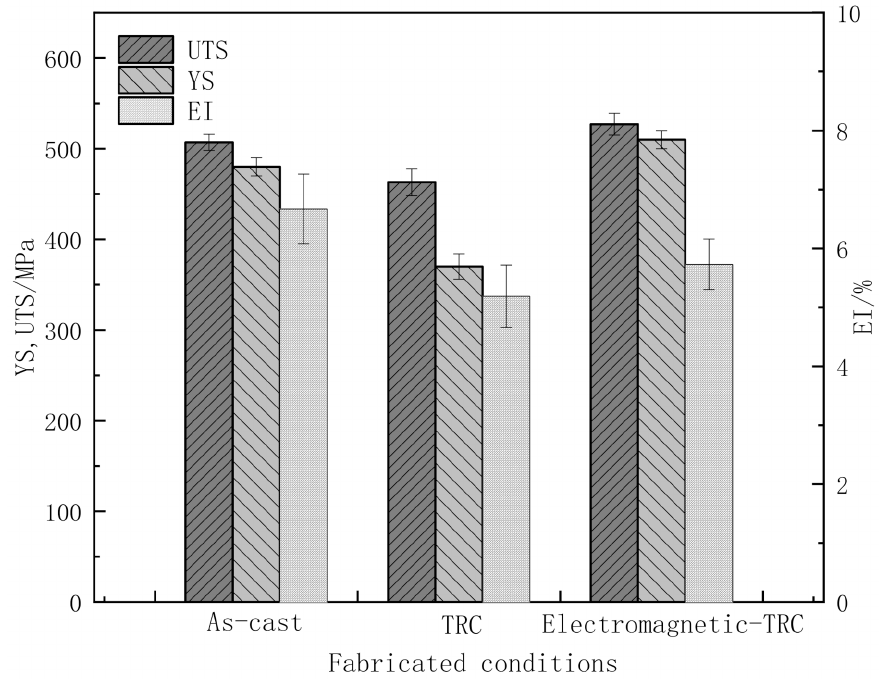
Figure 5. Effects of different preparation processes on mechanical properties of Al-Cu-Li